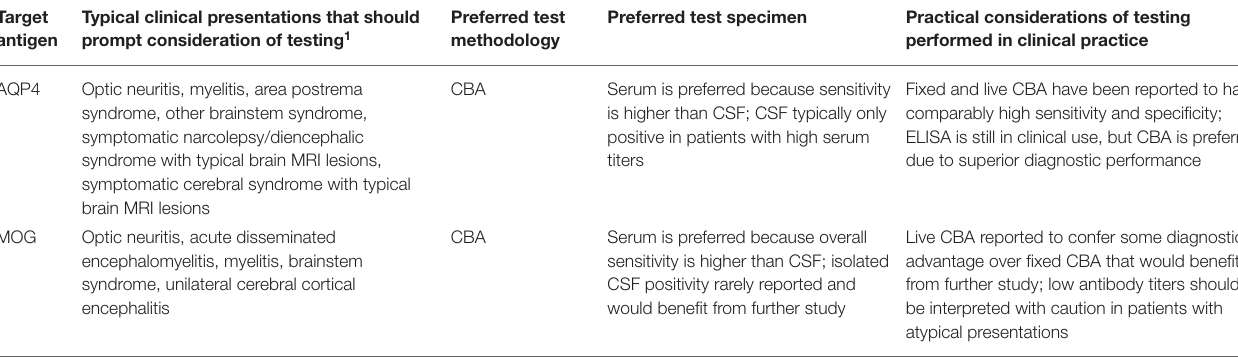
TABLE 1 | Key considerations when testing for antibodies against aquaporin-4 (AQP4) and myelin oligodendrocyte glycoprotein (MOG). Target Typical clinical presentations that should antigen prompt consideration of testing